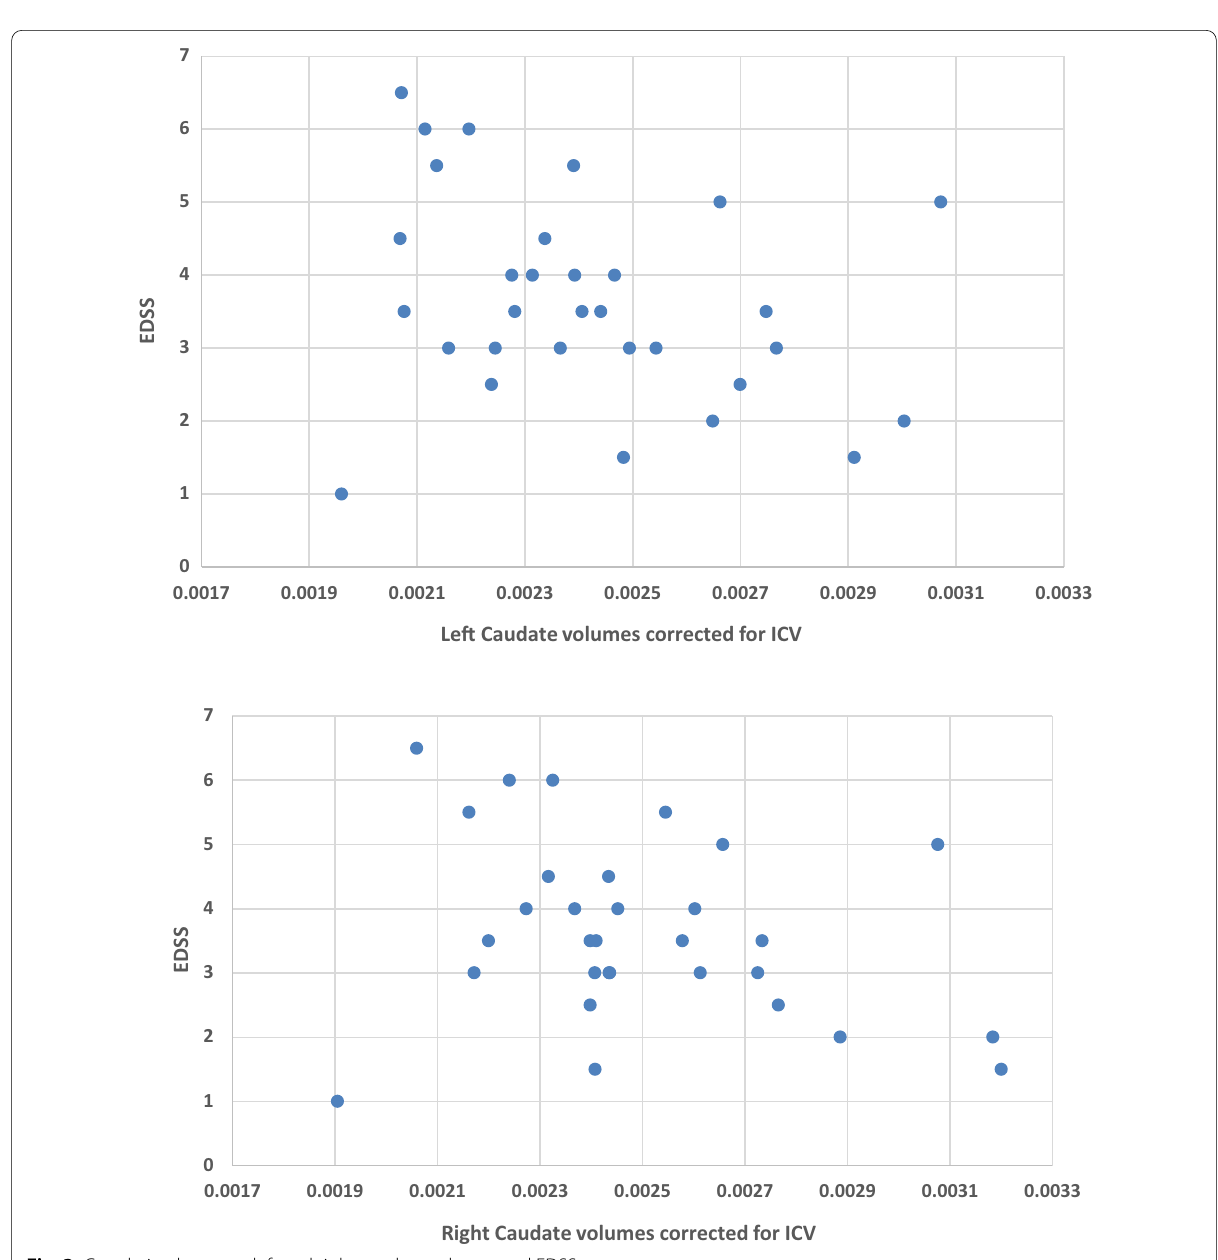
Fig. 3 Correlation between left and right caudate volumes and EDSS